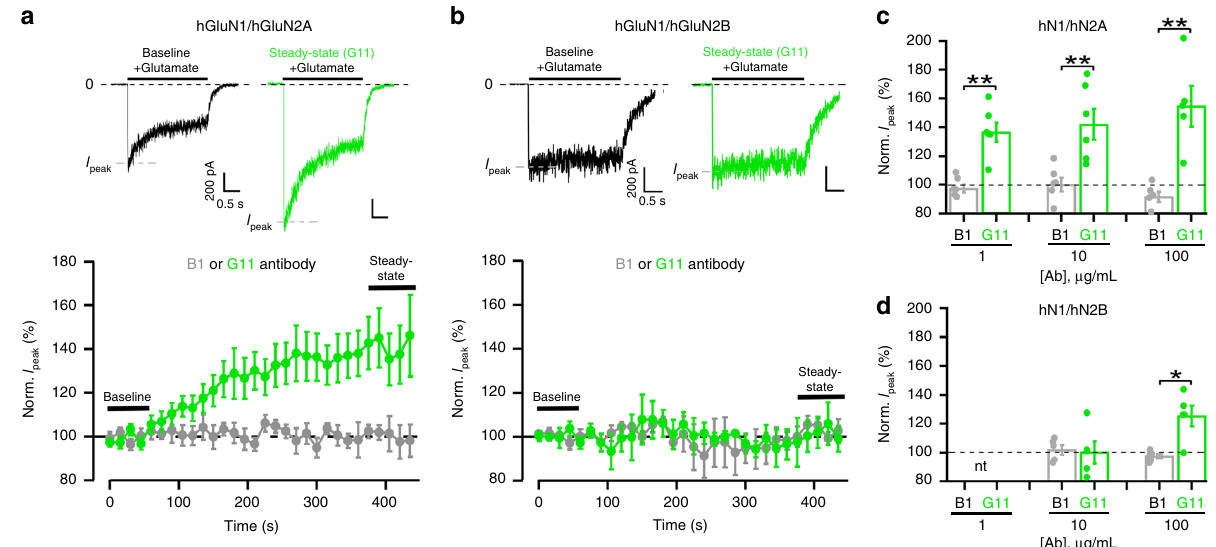
Fig. 1 Differential sensitivity of N2A- and N2B-containing NMDARs to DNRAbs. a , b Direct DNRAb application to NMDARs. Upper panels, whole-cell currents from HEK293 cells expressing human NMDAR subunits, either hGluN1/hGluN2A ( a ) or hGluN1/hGluN2B ( b ) at 10 µ g/mL. Currents were elicited by a 2.5 s application of glutamate (1 mM) in the continuous presence of glycine (0.1 mM) (holding potential, − 70 mV). Lower panels, control antibody B1 (IgG1, gray circles) or human-derived DNRAb G11 (green circles) were added 75 s after a baseline recording of fi ve sweeps, and were included in the bath throughout the remaining period. Current amplitudes for individual recordings were normalized to its baseline. Values are mean ± SEM (hN2A + B1, n = 6; hN2A + G11, n = 6; hN2B + B1, n = 5; hN2B + G11, n = 5; n = cells recorded). Example traces in upper panels show the + G11 recordings for the initial sweep during baseline (no antibody present) or for the last sweep during steady-state (in antibody). Ca 2 + is not present in the extracellular solution to minimize run-down over time. c , d Peak current amplitudes in N2A-containing NMDAR are more strongly potentiated than those in N2B-containing receptors. Bar graphs (mean ± SEM with dots indicating individual values) (from left to right for hN1/hN2A, n = 6, 6, 6, 6, 5, 5 cells recorded; and for hN1/hN2B, n = 5, 5, 6, 5 cells recorded) showing normalized steady-state peak current amplitudes either for control antibody (B1) or DNRAbs (G11). Signi fi cance of DNRAb values are measured relative to their respective control ( *p < 0.05 or **p < 0.01 , two-sided t test) (left to right for N2A, p = 0.00137, 0.00932, 0.00906; left to right for N2B, p = 0.855, 0.0163). nt, not